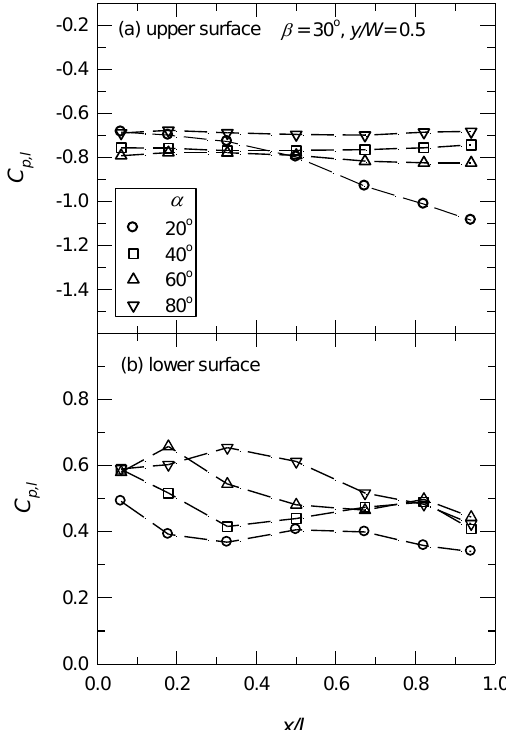
Figure 3. Mean longitudinal pressure distributions for y/W = 0.5 and β = 30°.